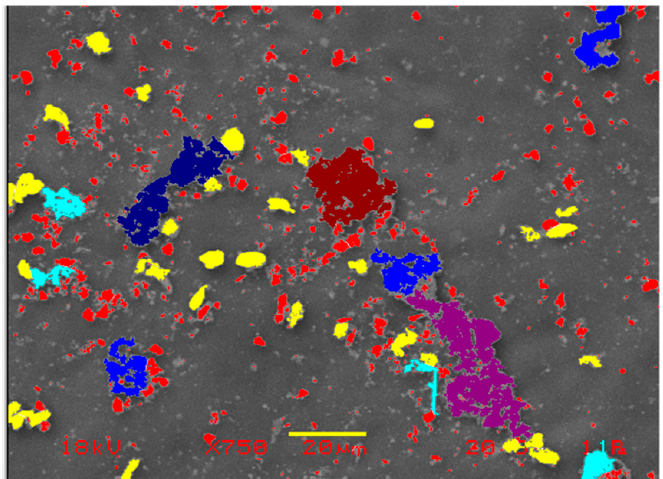
Figure 4. Particulate matter deposition on a biological surface. Colors indicate the dimensional ranges of particles: red, ∅ < 1 µm; yellow, ∅ ∼ 4 µm; light blue, ∅ ∼ 8 µm; blue/dark blue, ∅ ∼ 11.5 µm. Dimensional bar = 20 µm. Photo courtesy of Professor G. Lorenzini (University of Pisa, Italy), kindly acknowledged.